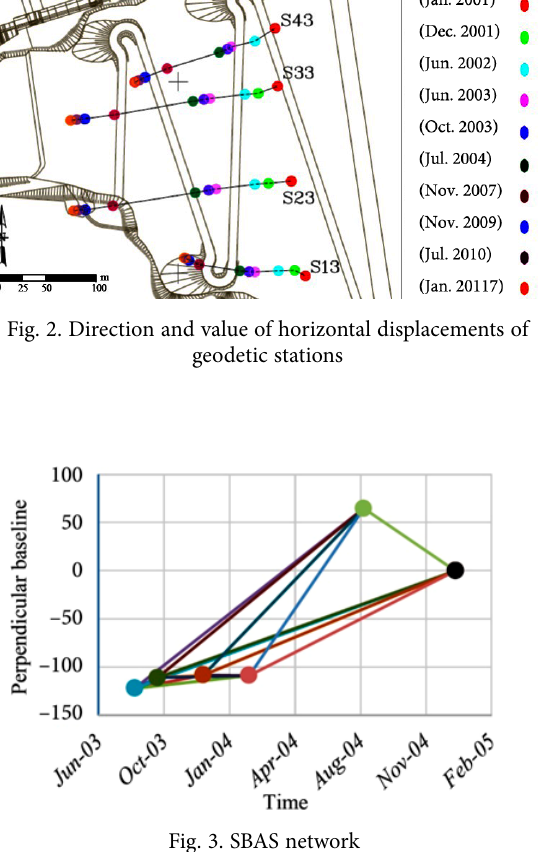
Fig. 3. SBAS network